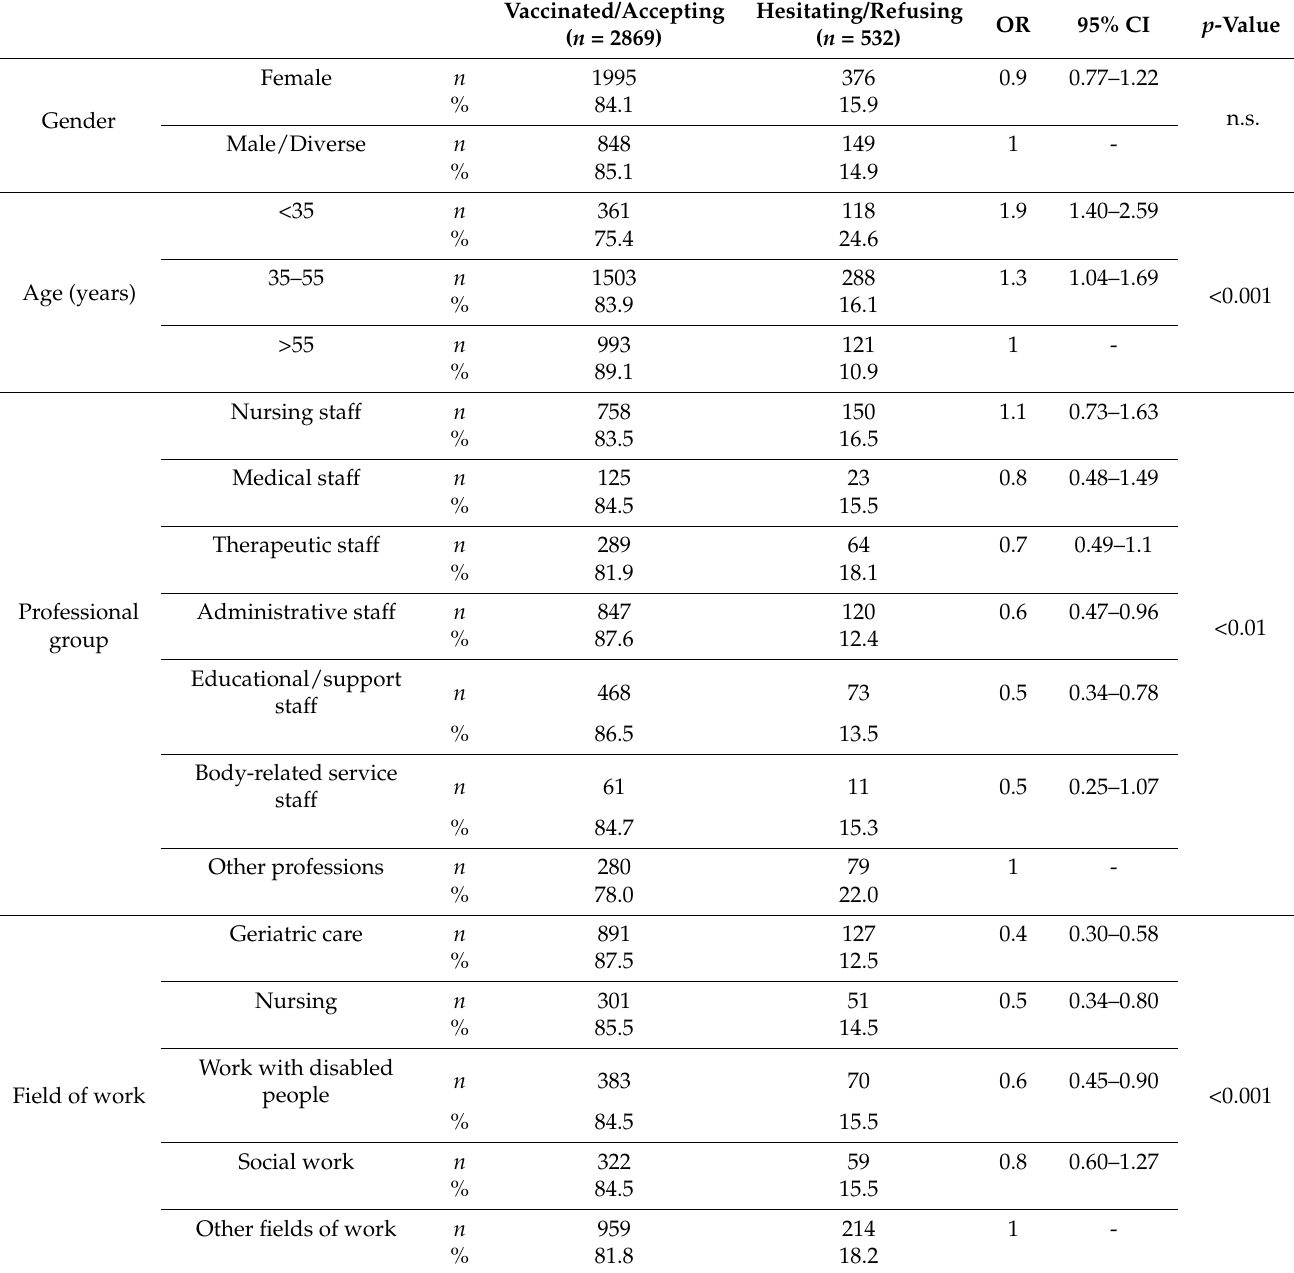
Table 3. Factors associated with hesitancy or refusal to be vaccinated against